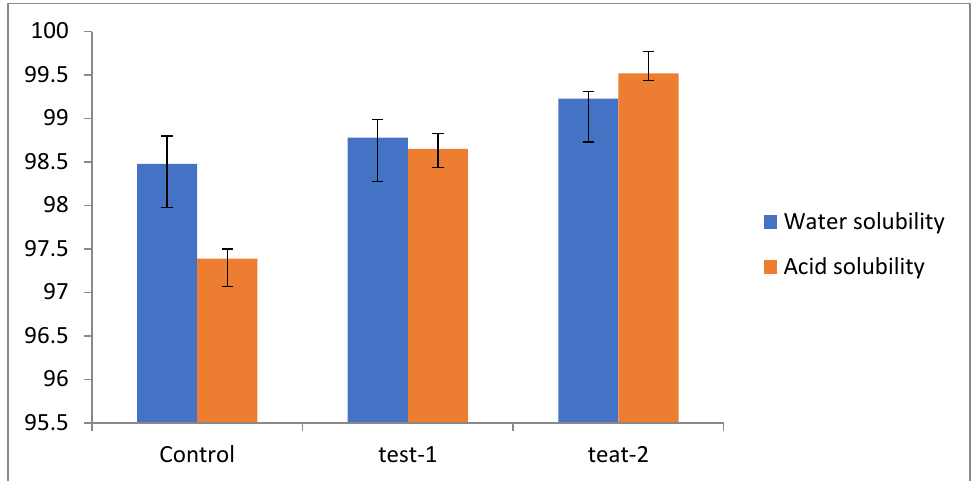
Figure 3. Solubility index of different films: control (pectin + glycerol); test-1 (flax + pectin + glycerol); test-2 (flaxseed + glycerol). The error bars indicate the standard deviation of means n = 3 ( p ≤ 0.05).